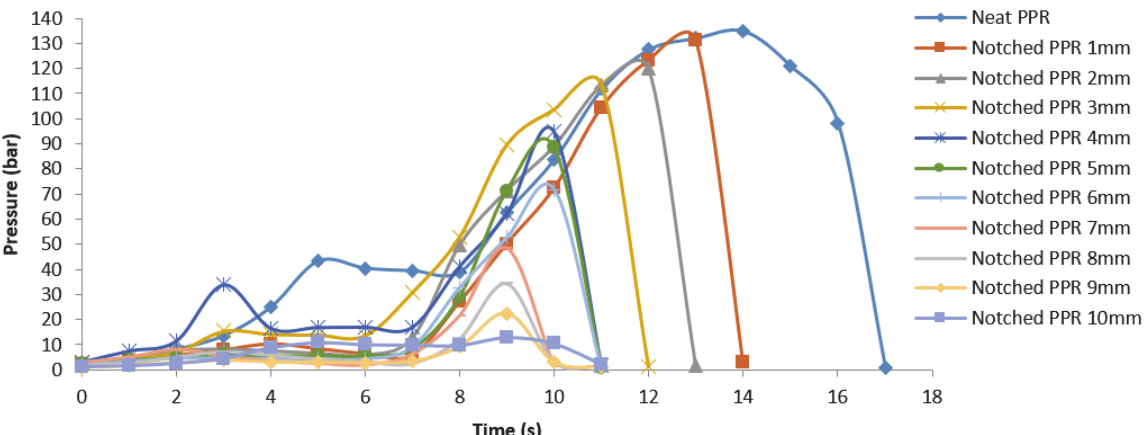
Figure 4: Internal pressure evolution for neat and notched PPR pipes.